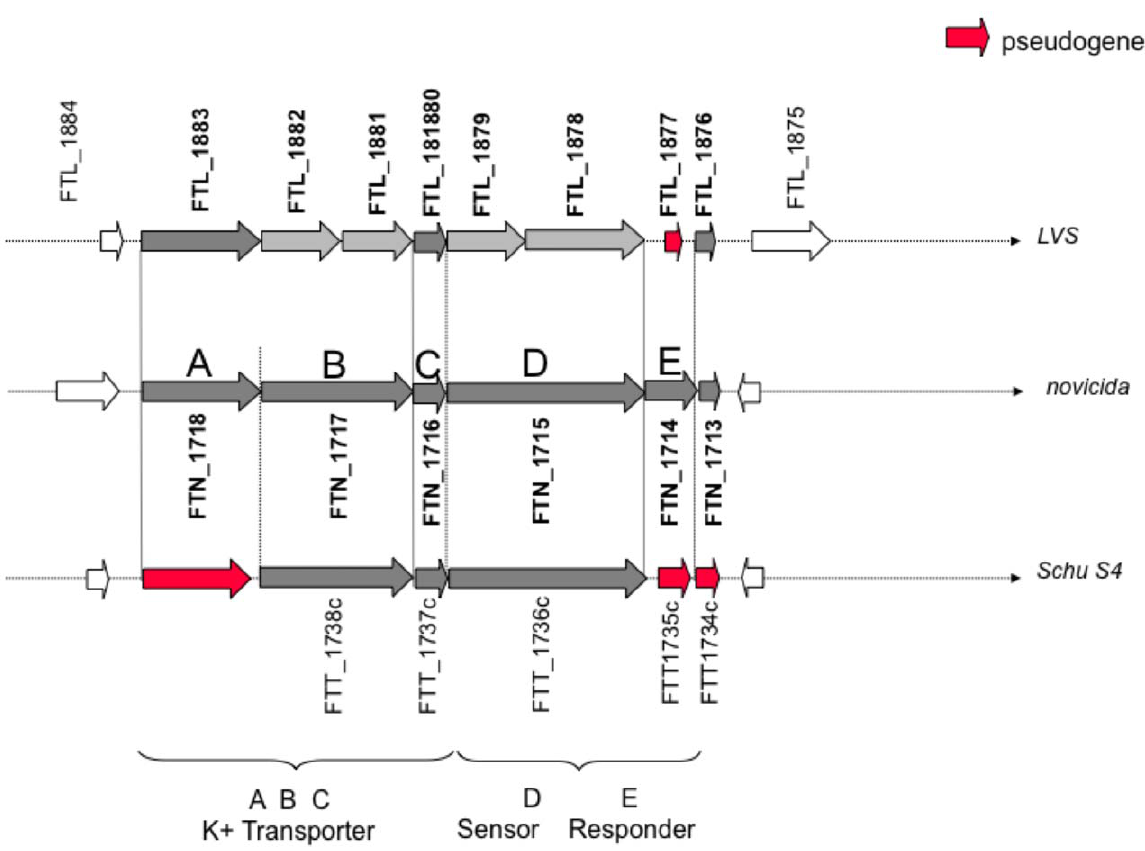
Figure 2. The kdp locus in F.tularensis subsp. holartica (LVS), novicida , and tularensis . The prototypical Kdp potassium transport system comprises: i) the transporter, composed of KdpA, KdpB and KdpC; and ii) the TCS, regulating its expression, and composed of KdpD, the sensor kinase; and KdpE, the response regulator. Upper line, the LVS locus. Whenever an FTL number has been attributed, it is indicated above the orf . Middle line, F. tularensis subsp. novicida which comprises an intact kdp locus. A, B, D and E, above each gene refer to kdpA , kdpB , kdpC , kdpD and kdpE , respectively. Lower line, F. tularensis subsp. tularensis . In dark grey, the intact genes; in light grey, the interrupted genes (but annotated as genes in the KEGG database); in red, the interrupted genes annotated as pseudogenes (in KEGG). KdpB . In F. tularensis subsp. novicida , the kdpB gene ( FTN_1717 ; 2,040 bp) encodes a 679 aas protein. In LVS, the proximal portion of the gene carries: i) an in frame 63 bp deletion (deletion of nucleotides 509 to 571); and ii) a single nucleotide insertion (between nucleotides 1,096 and 1,097; FTN_1717 numbering), leading to a premature termination of the coding sequence (creation of a TGA stop codon 9 bp downstream of the insertion). The resulting 374 aas truncated protein is designated FTL_1882 . An ATG codon (in frame with the rest of the kdpB sequence of FTN_1717) is found immediately downstream of the stop codon (29 bp) of FTL_1882 , leading to the prediction of a second open reading frame of 301 aas designated FTL_1881 . Blastn analysis of the nucleotide sequence of LVS corresponding to gene FTN_1717 ( i.e. 1,978 bp from the start codon of FTL_1882 to the stop codon of FTL_1881 ) reveals that the entire LVS sequence is 100% identical to F. tularensis subsp. holarctica FTNF002-00 genome region 1,811,308 to 1,809,331 and . 99% identical to F. tularensis subsp. holarctica OSU18 genome region 1,815,047 to 1,813,070 (with a unique C to A substitution at position 71 of FTL_1882 ). Thus, in the three subsp. holarctica genomes available, the proximal part of the kdpB gene carries the same in frame deletion and the gene is interrupted by the same single nucleotide insertion. KdpD . In F. tularensis subsp. novicida , the kdpD gene ( FTN_1715 ; 2,682 bp) encodes a 893 aas protein. In LVS, the corresponding gene is interrupted by a single nucleotide insertion (between nucleotides 981 and 982; FTN_1715 numbering), leading to a premature termination of the coding sequence (creation of a TGA stop codon 32 bp downstream of the insertion). The resulting truncated predicted orf is designated FTL_1879 (337 aa). An ATG codon (in frame with the rest of the kdpD sequence of FTN_1715) is found downstream of the stop codon (92 bp) of FTL_1879 , leading to the prediction of a second orf of 525 aas, designated FTL_1878 . Blastn analysis of the nucleotide sequence of LVS (2,683 bp) corresponding to gene FTN_1715 reveals that the entire LVS sequence is 100% identical to F. tularensis subsp. holarctica OSU18 genome region 1,812,395 to 1,809,713100 and 99% identical to F. tularensis subsp. holarctica FTNF002-00 genome region 1,808,656 to 1,805,974 (with 3 single nucleotide substitutions). Thus, in the three subsp. holarctica genomes available, the kdpD gene is interrupted by the same single nucleotide insertion. KdpE . In F. tularensis subsp. novicida , the kdpE gene ( FTN_1714 ; 687 bp) encodes a 228 aas protein. In LVS, the corresponding region is not predicted to encode a protein ( FTL_1877 is designated pseudogene). Comparison of the F. tularensis subsp. novicida and LVS nucleotide sequences reveal the presence of a 13 bp deletion in the proximal portion of the LVS sequence (deletion of nucleotides 45 to 57, FTN_1714 numbering), resulting in a frame shift and the premature termination of the protein sequence (a TGA stop codon is found 11 bp downstream of the deletion). Blastn analysis of the nucleotide sequence of LVS (671 bp) shows a 100% identity with the F. tularensis subsp. holarctica OSU18 genome region 1,809,671 to 1,809,001; and . 99% identity with F. tularensis subsp. holarctica FTNF002-00 genome region 1,805,932 to 1,805,262 (1 single nucleotide substitution) as well as with F. tularensis subsp. tularensis Schu S4 genome region 1,823,954 to 1,823, 284 (2 single nucleotide substitution). Thus, in the three subsp. holarctica genomes available and in Schu S4, the kdpE gene is a pseudogene resulting from the same 13 bp deletion. The regions containing the mutations in genes kdpB ( FTL_1881-1882 ), kdpD ( FTL_1878-1879 ) and kdpE ( FTL_1877 ), have been resequenced by sequencing of cloned PCR products. This analysis fully confirmed the published sequence of LVS.